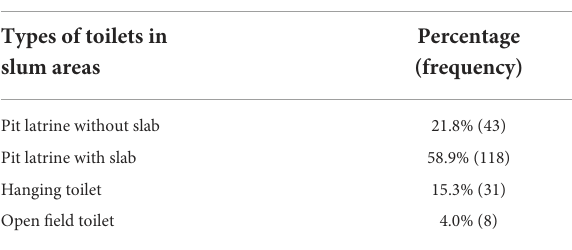
TABLE 2 Types of toilets and problems of using toilets in slum areas. Types of toilets in slum